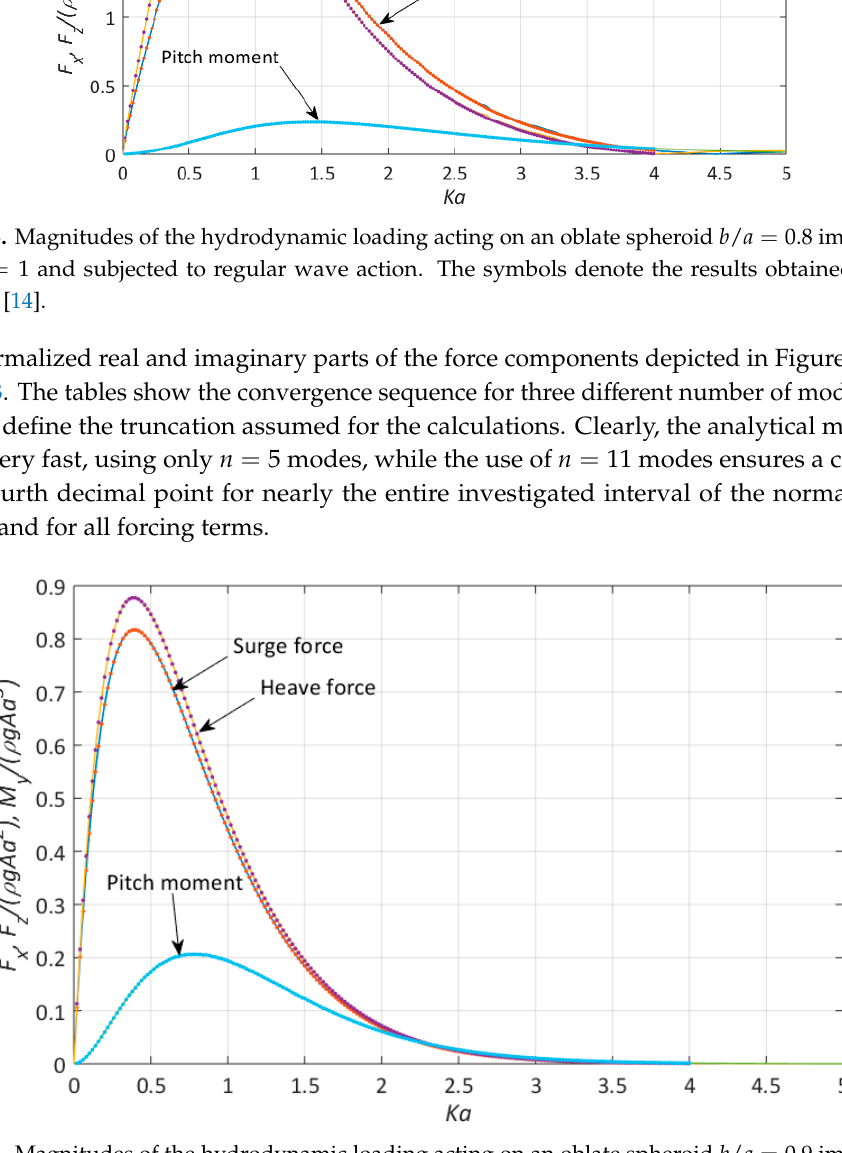
Figure 4. Magnitudes of the hydrodynamic loading acting on an oblate spheroid 𝑏 𝑎⁄ = 0.9 immersed at 𝑓 𝑎⁄ = 2.5 and subjected to regular wave action. The symbols denote the results obtained using WAMIT [14]. The pitch moments have been multiplied by 10 for display purposes. Table 1. Convergence sequence of the computations in terms of the real and imaginary parts of the normalized surge force 𝐹 (cid:3051) 𝜌𝑔𝐴𝑎 (cid:2870) ⁄ for different mode numbers. Slenderness of the oblate spheroid is 𝑏 𝑎⁄ = 0.8 with an immersion of 𝑓 𝑎⁄ = 1.0 . The normalization is that of Equation (43).